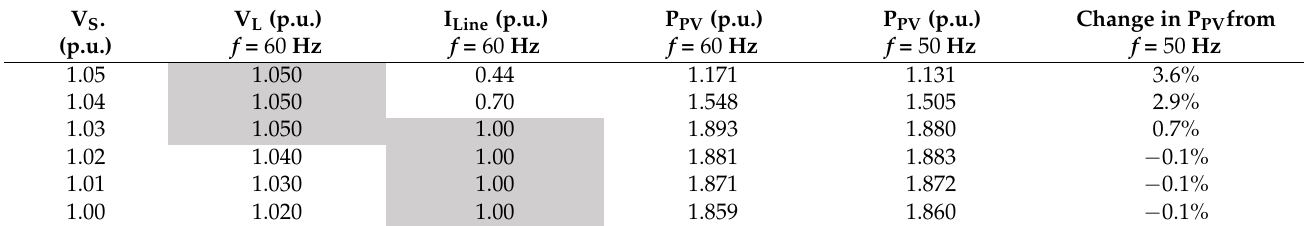
Table 8. Effect of system frequency on maximum PV penetration limit for the UGC.